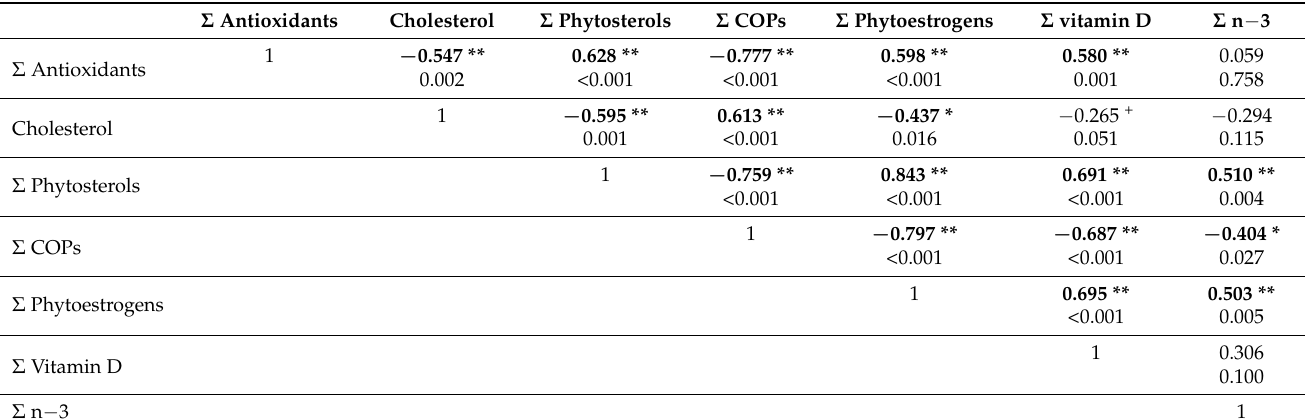
Table 5. Matrix of Pearson